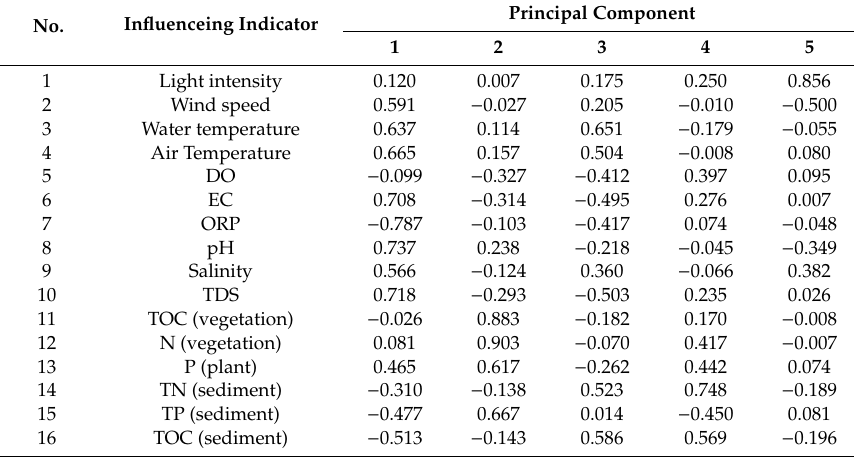
Table 2. Principle component matrix for influencing factors of GHGs emissions.